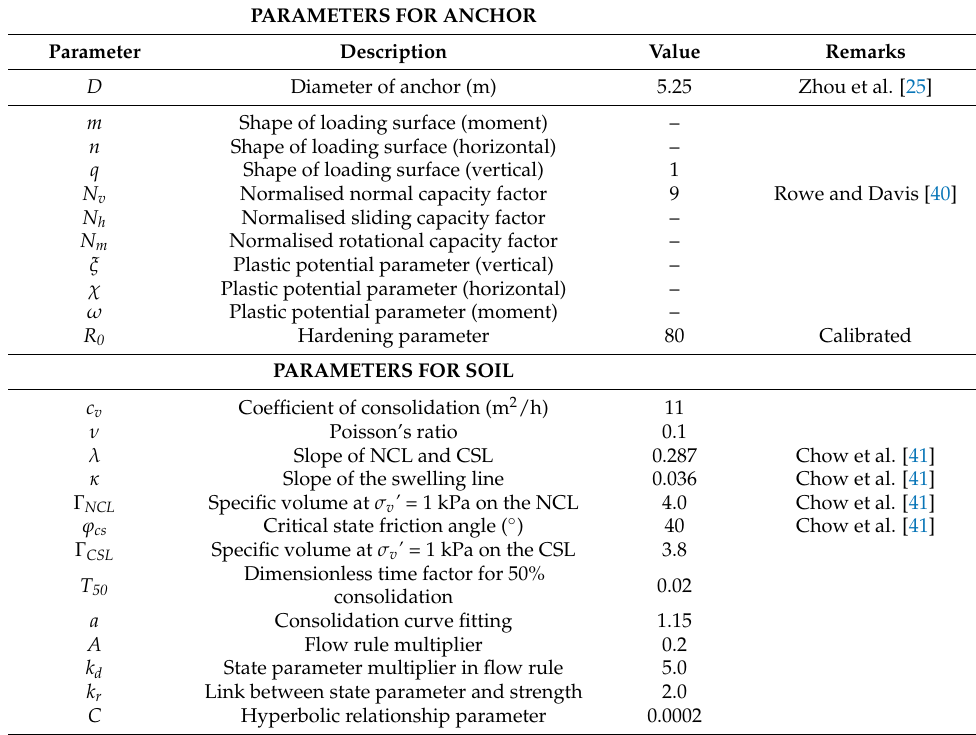
Table 1. Geometry and modelling parameters used for Scenario